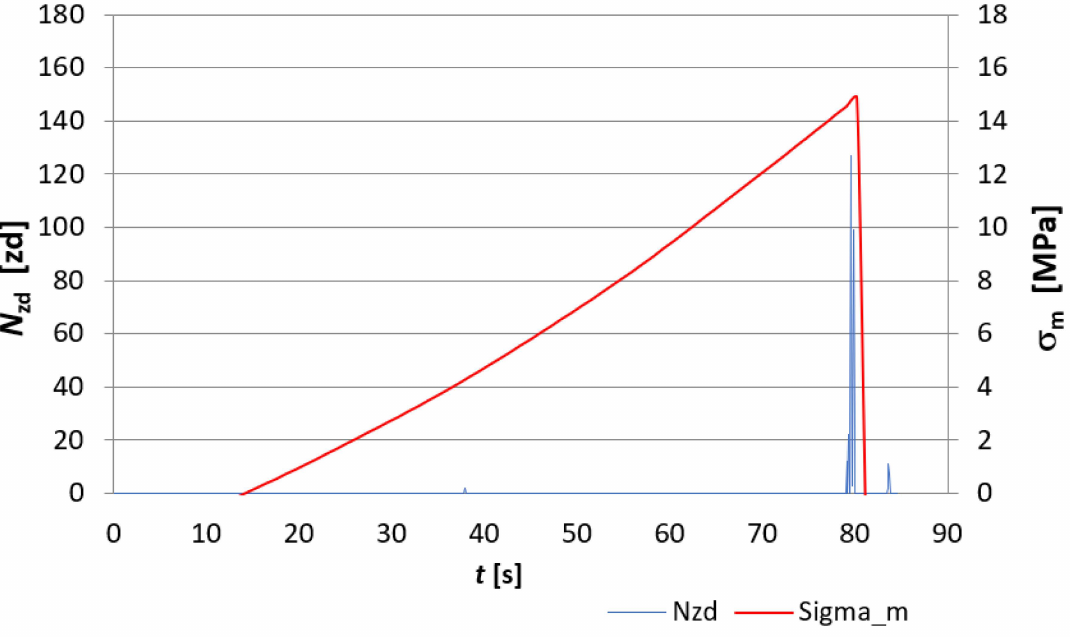
Figure 9. Recording of the event rate N zd and bending stress σ m versus time for the D4